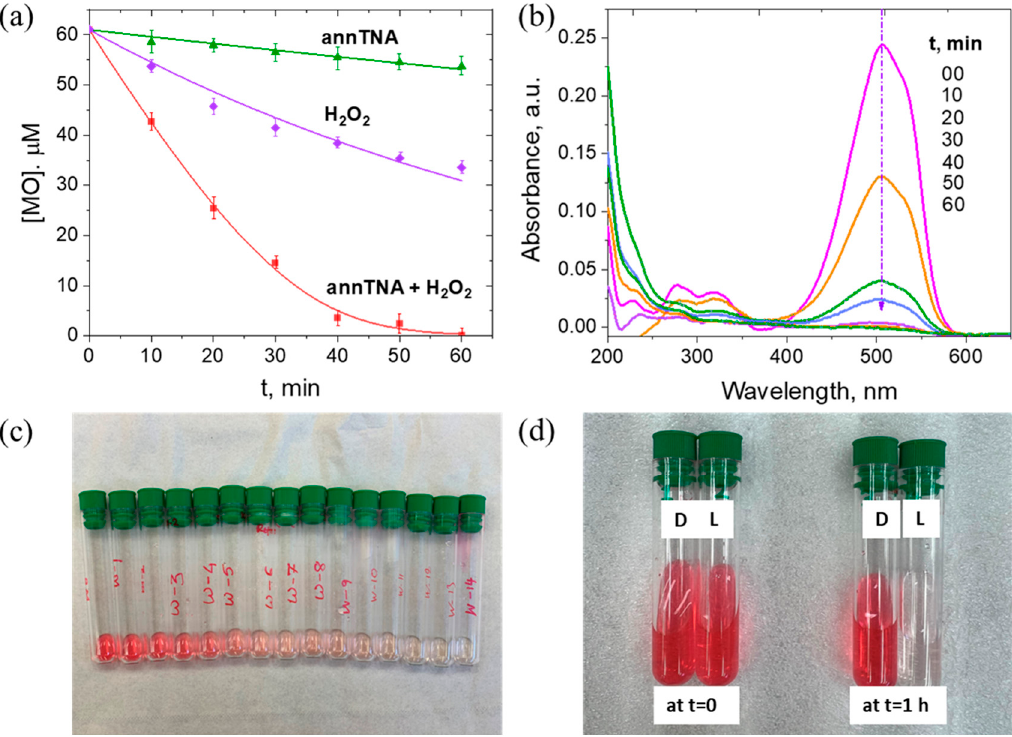
Figure 2. ( a ) Time-profiled MO degradation: (purple) H 2 O 2 only, (green) annTNA film alone, and (red) annTNA film + H 2 O 2 . Experimental conditions: initial [MO] = 20 ppm, [H 2 O 2 ] = 55 mM, medium pH = 3.4, under solar irradiation (AM 1.5 G, 100 mW cm − 2 ). Symbols represent experimental kinetic data and lines are nonlinear regressions with the Langmuir–Hinshelwood (L–H) model. ( b ) UV–Visible light absorbance measurements of the change in MO dye concentration at 5 min intervals for the annTNA+H 2 O 2 system. Photographs of MO dye solutions degraded by the annTNA + H 2 O 2 system: ( c ) taken at regular time intervals in light and ( d ) before and after 1 h in the dark (D) and light (L).